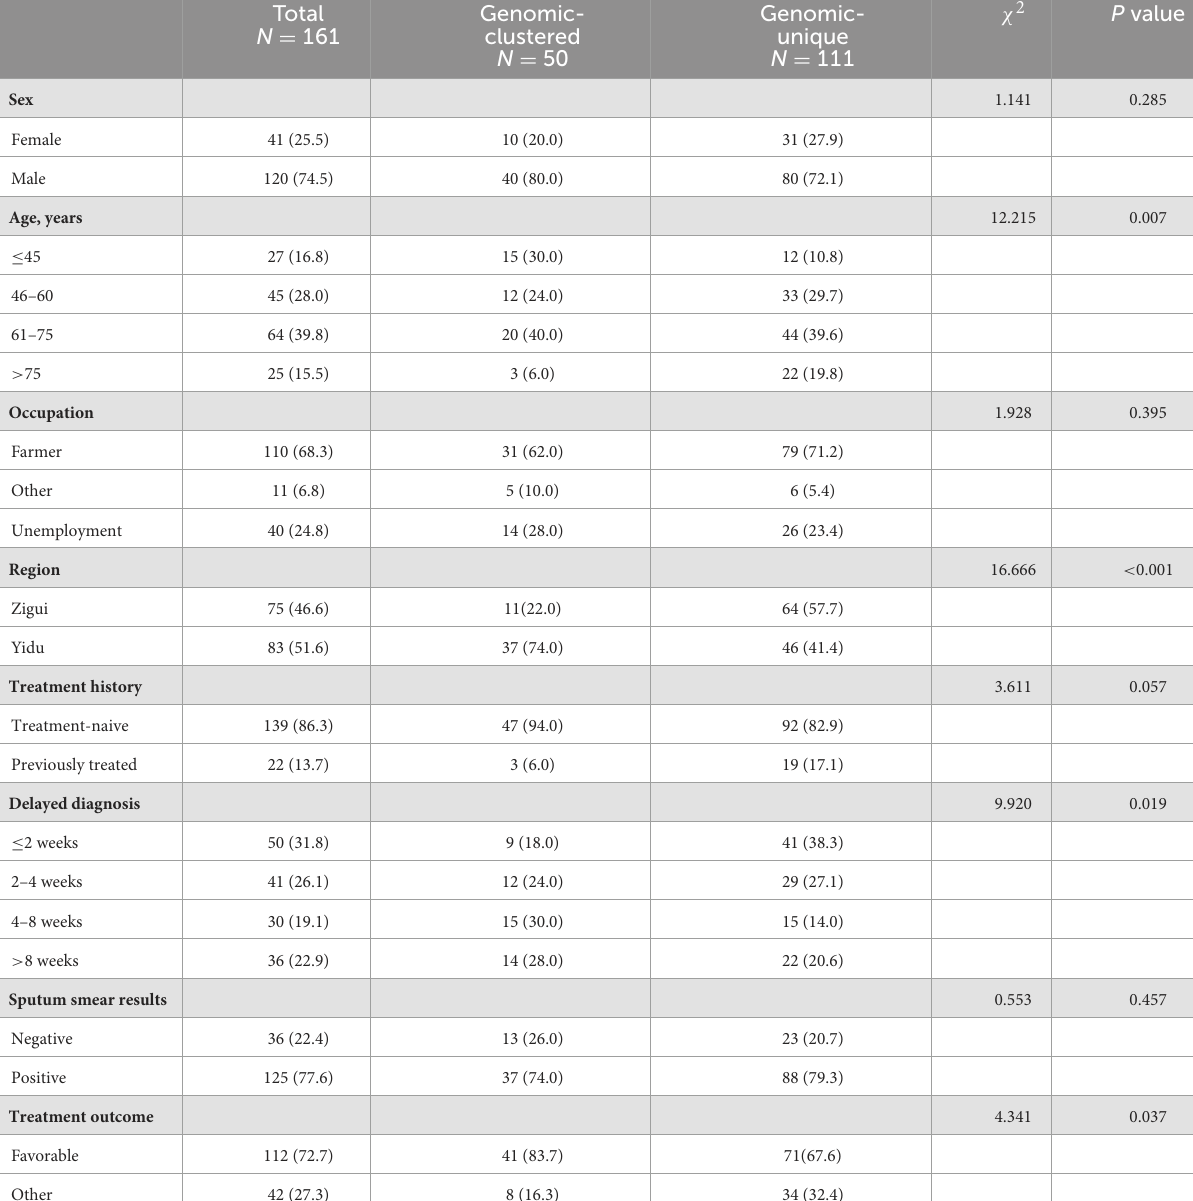
TABLE 3 Demographic and pathogenic characteristics of genomic-clustered and non-clustered